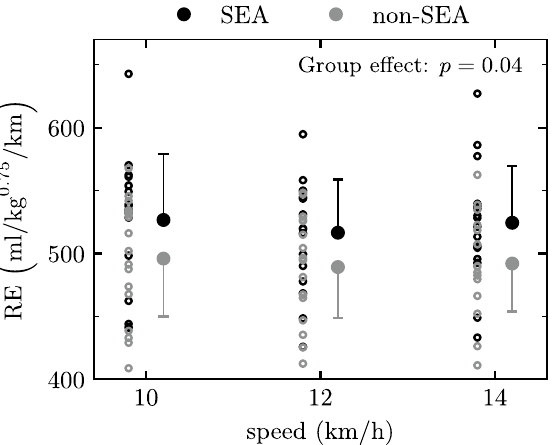
Figure 2. Running Economy (RE) of South East Asian (SEA) and non-South East Asian (non-SEA) runners at several endurance running speeds. Linear mixed effects modelling identified a significant group effect ( p ≤ 0.05).